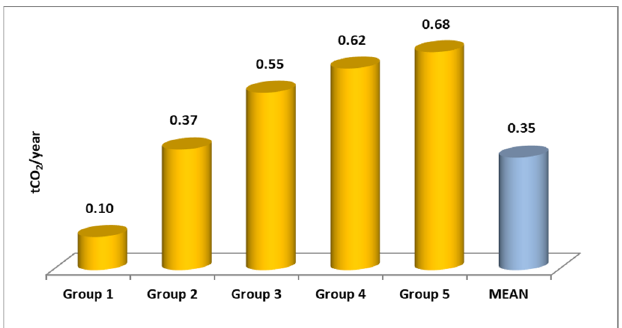
Figure 14. Mean CO 2 emissions per inhabitant by group of cities.